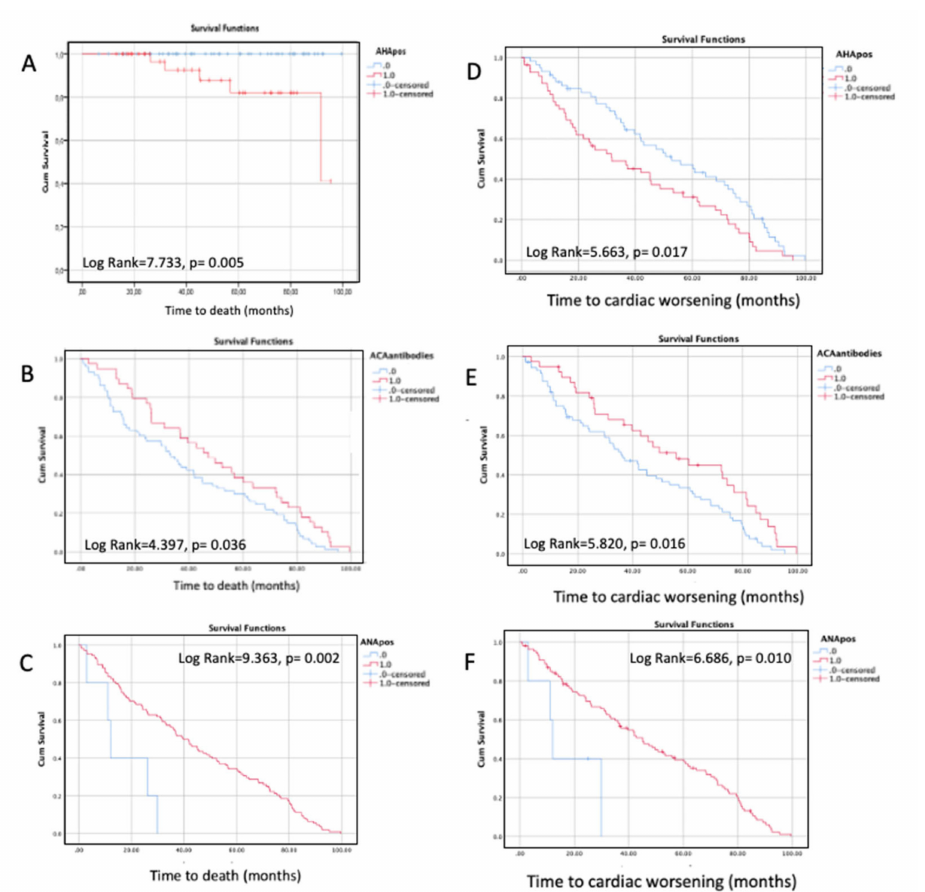
Figure 2. Survival curves according to auto-antibodies status. ( A ) Kaplan–Meier survival curves in systemic sclerosis (SSc) patients according to Anti-Heart Autoantibodies (AHA) status. AHA positive SSc patients have lower survival ( p = 0.005). ( B ) Kaplan–Meier curves comparing survival in systemic sclerosis (SSc) patients as a function of Anti-Centromere Autoantibody (ACA); ACA positive SSc patients have better survival ( p = 0.036). ( C ) Anti-Nuclear Autoantibody (ANA) status. ANA positive SSc patients have better survival ( p = 0.002). Kaplan–Meier curves in systemic sclerosis (SSc) comparing time to cardiac worsening as a function of ( D ) Anti-Heart Autoantibodies (AHA), AHA positive SSc patients have lower survival free from cardiac worsening ( p = 0.017); ( E ) Anti-Centromere Autoantibody (ACA), ACA positive SSc patients have higher survival free from cardiac worsening ( p = 0.016); ( F ) Anti-Nuclear Autoantibody (ANA) status. ANA positive SSc patients have higher survival free from cardiac worsening ( p = 0.010). In all curves, 0 = negative antibody status, 1 = positive antibody